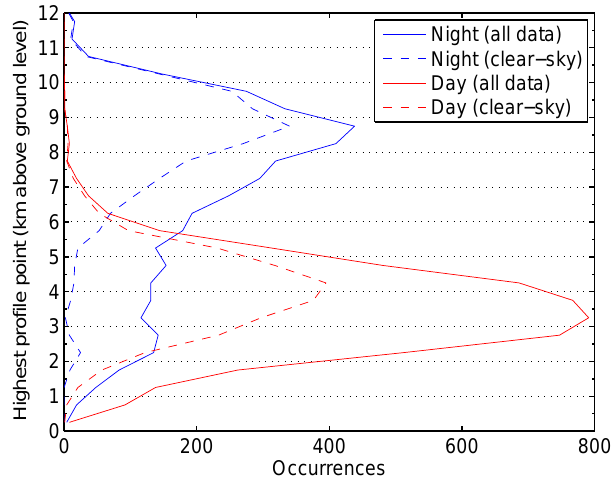
Fig. 4. Distribution of highest point in lidar profiles for clear-sky (dotted) and all-sky (solid) during night (blue) and day (red). Period: 1 October 2009 to 30 September 2010. Number of profiles: 9’086.